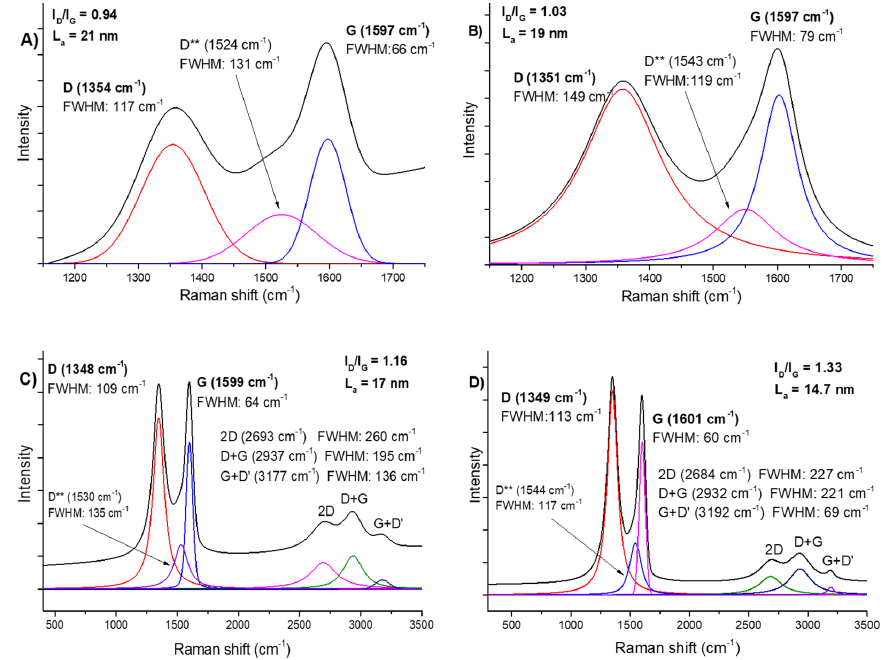
Figure 2. Raman spectra of the GO-sf ( A ), GO-lf ( B ), rGO-lr ( C ), and rGO-hr ( D ) samples. Legend: GO-lf: graphene oxide with large flakes (10–20 µm), GO-sf: graphene oxide with small flakes (0.2–2 µm), rGO-lr: reduced graphene oxide with low reduction level, and rGO-hr: reduced graphene oxide with high reduction level. The black lines in spectra presented in the Figure 2 (A, B, C, D) correspond peak sums, the colored lines depict single mods. For example, in Figure 2A: the red line corresponds to peak D, the pink line peak D **, the blue line peak